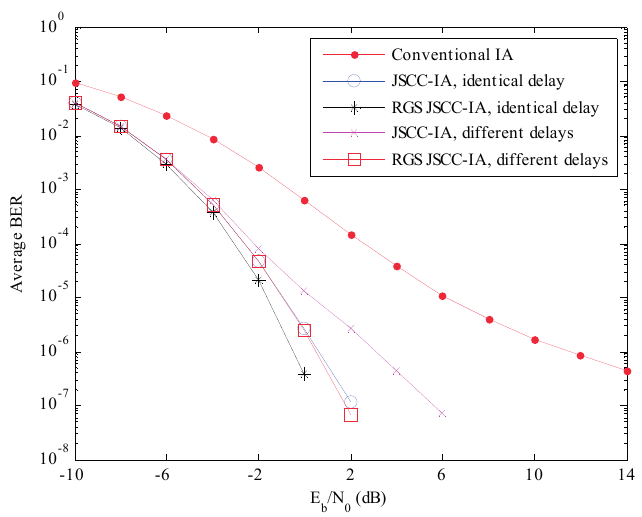
Figure 12. The average experimental BER performances of the conventional IA scheme, the JSCC-IA schemes with identical/different propagation delays and the RGS